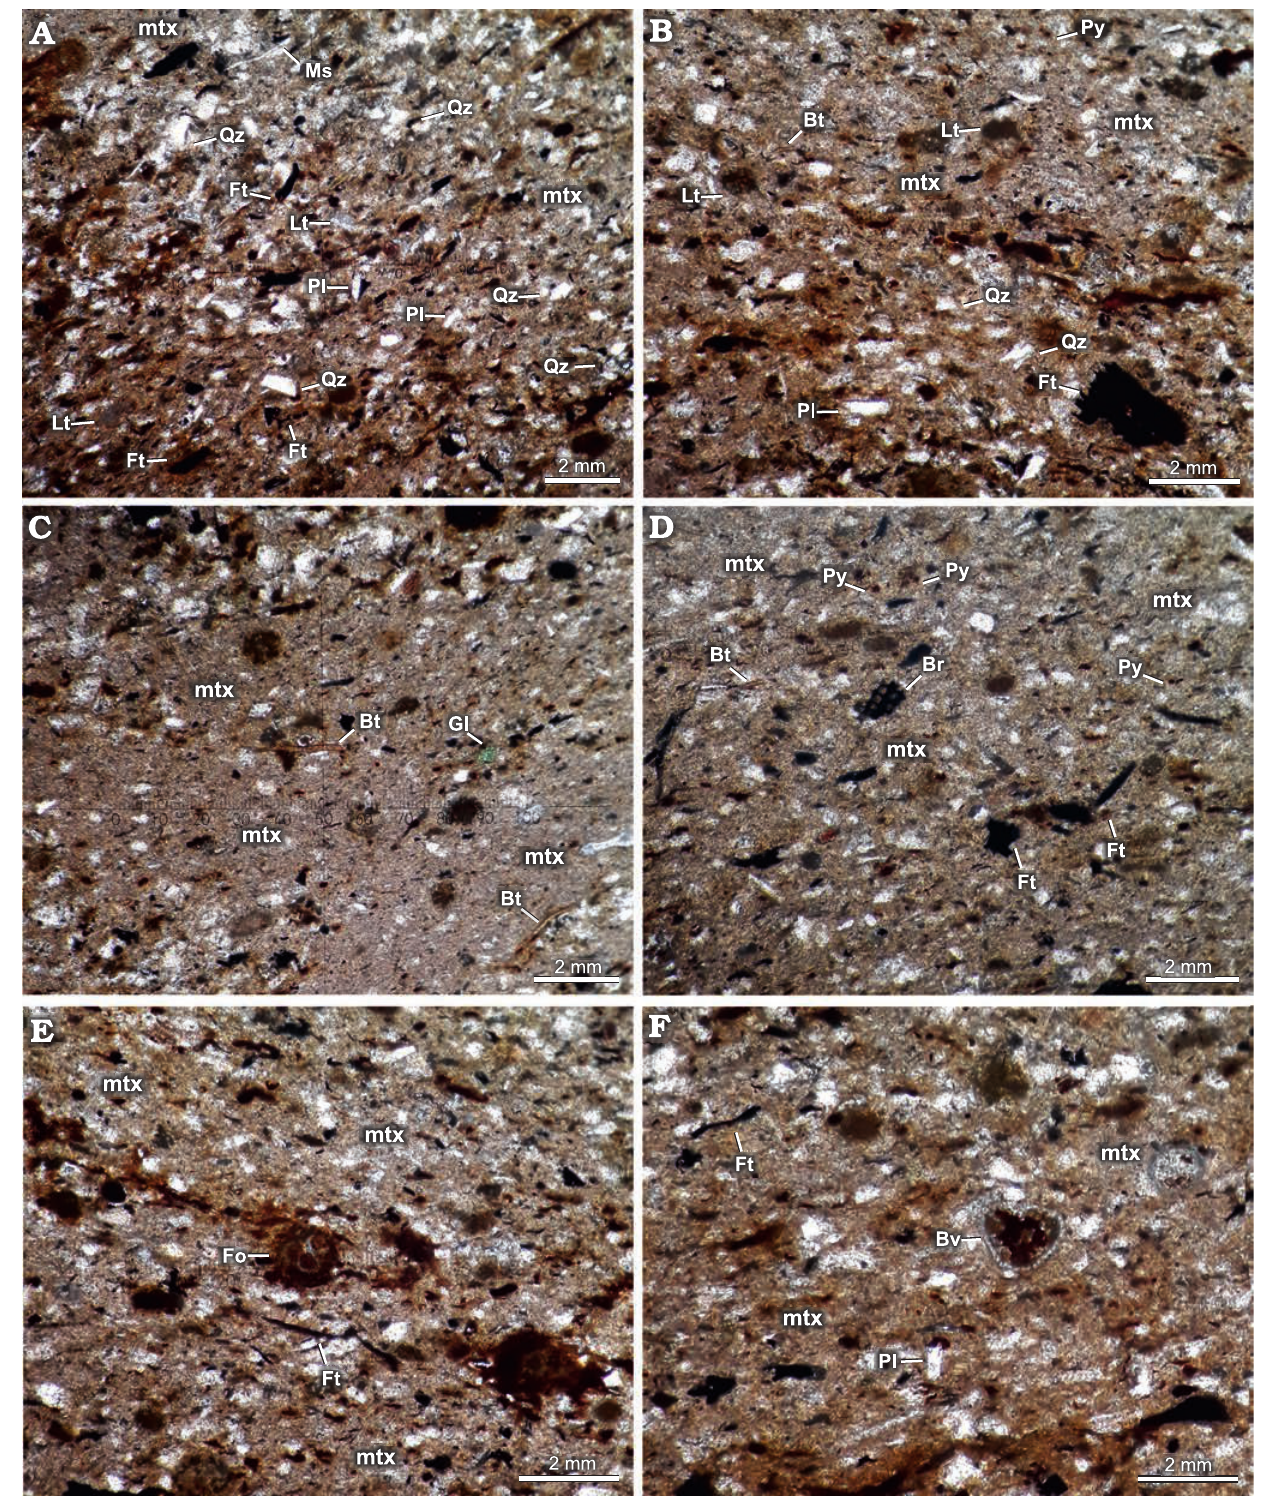
Fig. 3. Microscopic characteristics of the ophiuroid-bearing level. In all photomicrographs it is possible to identify the matrix (mtx). A . Photomicrograph of the level containing the ophiuroid fossil, showing phytodetritus (Ft), lithic fragments (Lt), muscovite (Ms), plagioclase (Pl), and angulose quartz (Qz). B . Photomicrograph of the level containing the ophiuroid fossil, showing biotite (Bt), phytodetritus (Ft), lithic fragments (Lt), plagioclase (Pl), fram- boidal pyrite (Py), and angulose quartz (Qz). C . Photomicrograph of the level containing the ophiuroid fossil showing biotite (Bt) and glauconite (Gl). D . Photomicrograph of the level containing the ophiuroid fossil showing fragments of bryozoans (Br), biotite (Bt), phytodetritus (Ft), and framboidal pyrite (Py). E . Photomicrograph of the level containing the ophiuroid fossil showing foraminifera (Fo), and phytodetritus (Ft). F . Photomicrograph of the level containing the ophiuroid fossil showing piritized bivalve (Bv), phytodetritus (Ft), and plagioclase